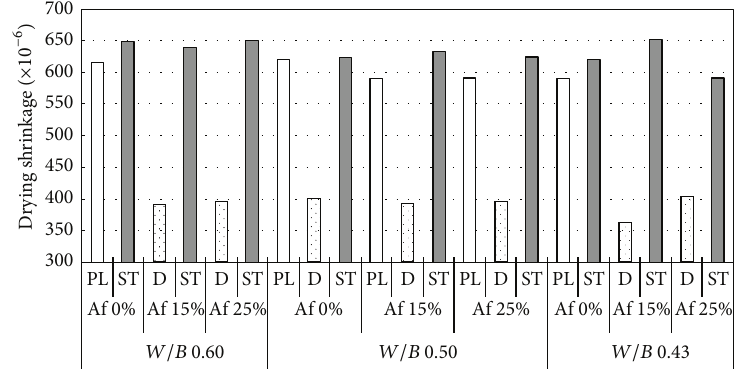
Figure 5: Drying shrinkage of ST, PL, and D concrete at 13